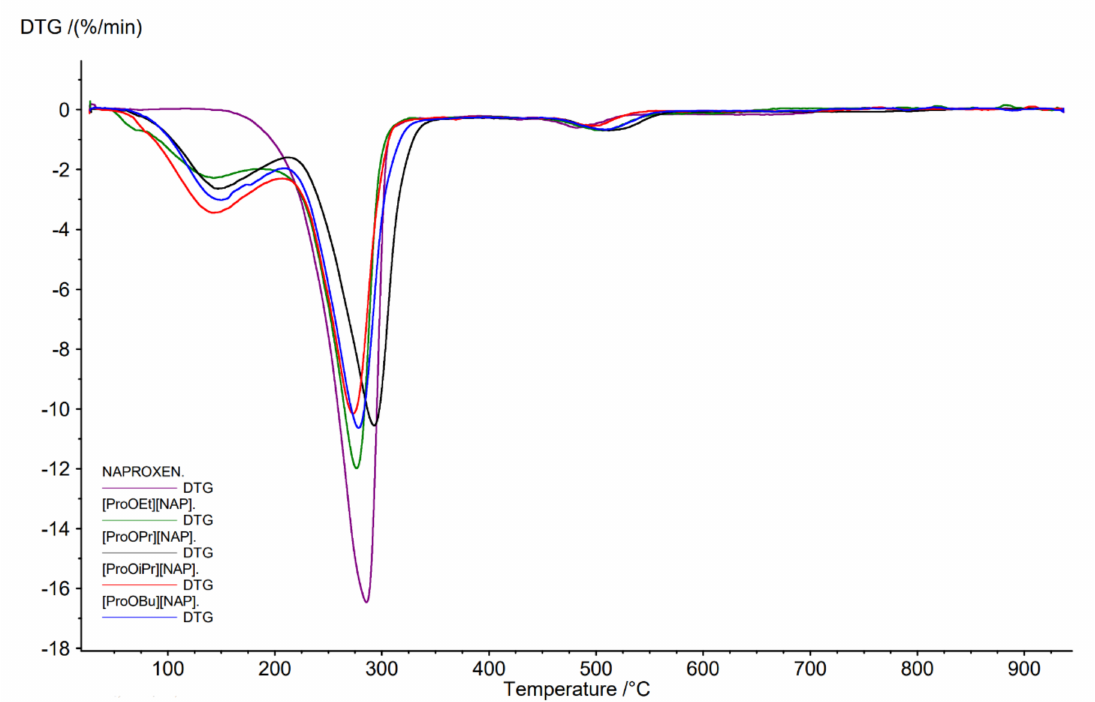
Figure 7. The DTG curves of naproxen (purple), and L-proline alkyl ester naproxenates-[ProOEt][NAP] (green), [ProOPr][NAP] (black), [ProOiPr][NAP] (red), and [ProOBu][NAP]